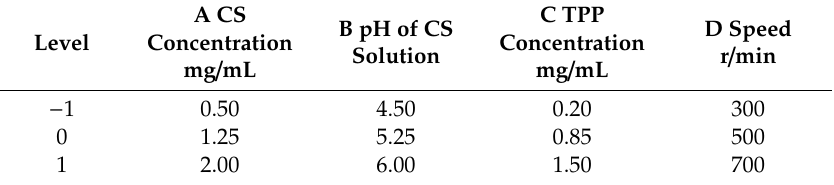
Table 1. Box–Behnken response surface optimization experiment factor level